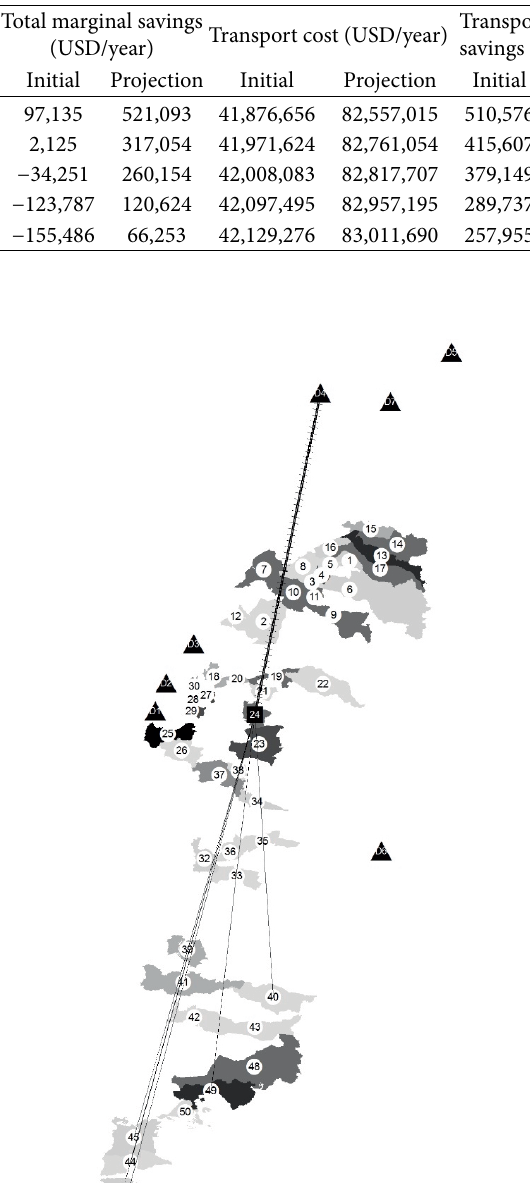
Table 2: Ranking of hubs.